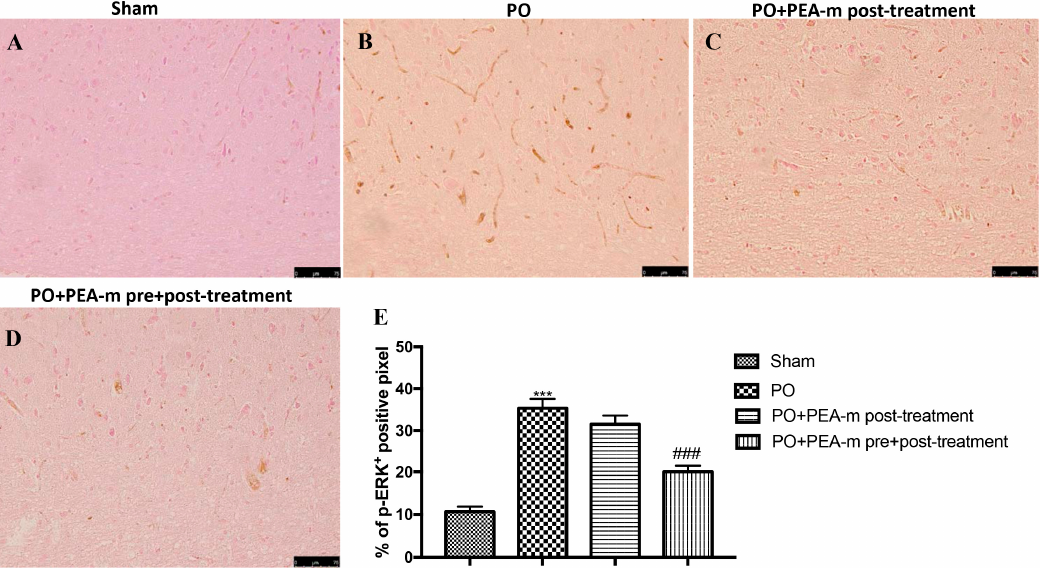
Figure 4. Effects of PEA-m on levels of phospho-extracellular signal-regulated kinase (p-ERK). Immunohistochemical analysis showed no staining for p-ERK in the sham group (A). Increased p-ERK expression was observed in lumbar spinal cord collected 24 h after PO (B). A non-significant reduction was observed in the PO + PEA-m post-treatment group (C), while low levels of p-ERK were found in rats treated with PEA-m both before and after plantar incision (D). The data are also presented graphically as a percentage of positive cells (E). *** p < 0.001 vs. sham; ### p < 0.001 vs.